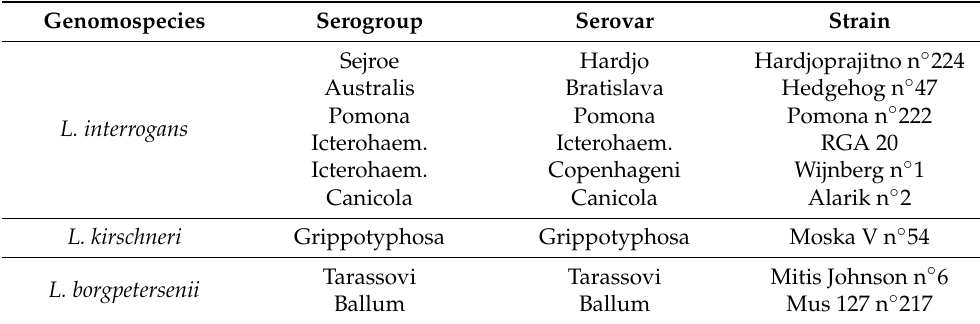
Table 2. Genomospecies, serovar, strain, and serogroup of Leptospira used as antigens for the microscopic agglutination